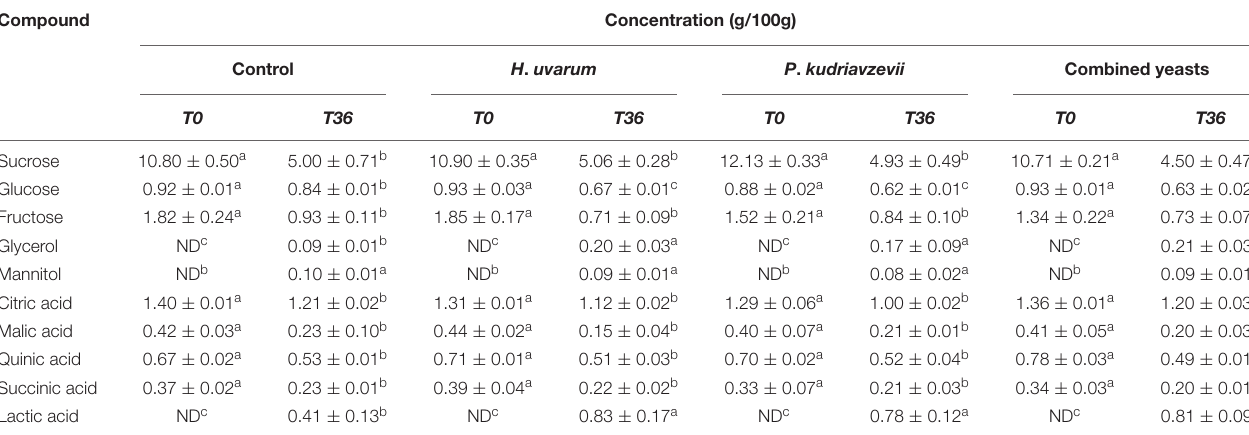
TABLE 3 | Comparison of chemical composition and microbial metabolites in the endosperm of coffee beans undergone spontaneous (control) and inoculated fermentations with H. uvarum , P. kudriavzevii and the two yeasts combined.